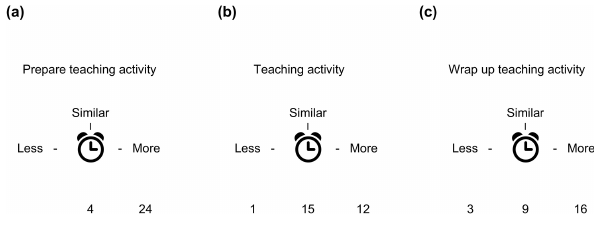
Figure 6. The amount of time (less, similar, or more) the respon- dents indicated having spent compared to pre-COVID-19 measures preparing the teaching activity (a) , during the teaching activity (b) , and wrapping up the teaching activity (c) . The numbers indicate the number of respondents.